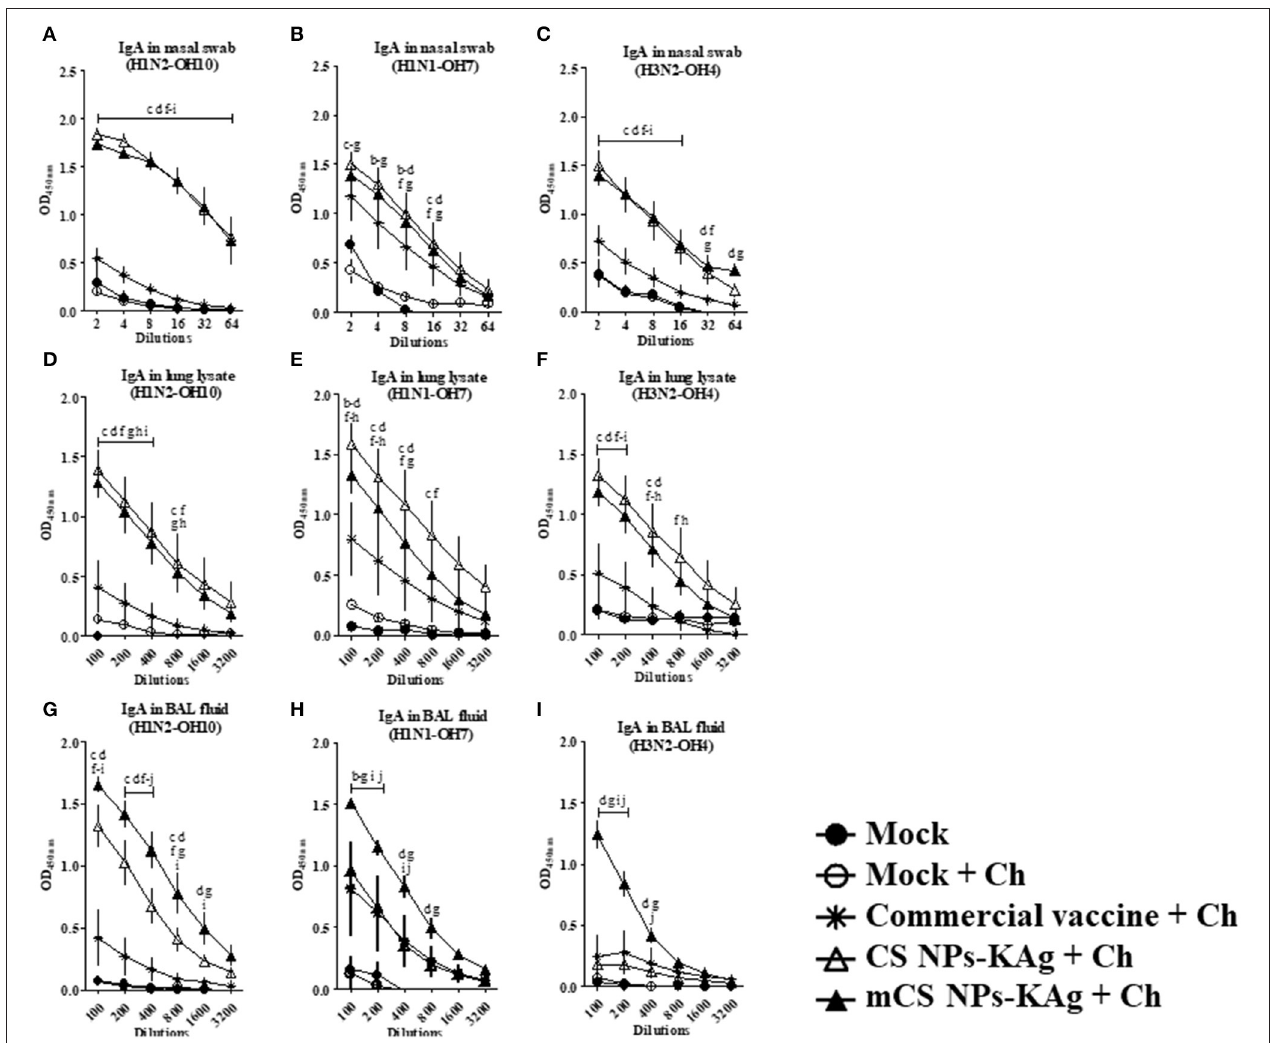
FIGURE 2 | Mannose-conjugated and unconjugated CS NPs based influenza (mCS NPs-KAg and CS NPs-KAg) vaccinates elicited higher cross-reactive secretory IgA antibody response in MDA-positive pigs post challenge infection. Pigs were prime-boost vaccinated with mCS NPs-KAg or CS NPs-KAg vaccine (containing H1N2-OH10 virus) intranasally or commercial vaccine (containing H1N1, H1N2, and H3N2 viruses) intramuscularly and at day post vaccination 35 challenged with a heterologous H1N1-OH7 virus. On day six post-challenge secretory IgA antibodies in nasal swab, lung lysate, and BAL fluid samples against (A,D,G) H1N2-OH10; (B,E,H) H1N1-OH7; and (C,F,I) H3N2-OH4 viruses were analyzed by ELISA. Data represent the mean value of three to four pigs ± SEM at all indicated dilutions. Statistical analysis was carried out using two-way ANOVA followed by a Bonferroni test. Each letter on the line graph indicates the significant difference between the groups at the marked sample dilution: b, c and d indicate the difference between mock group compared to commercial vaccine + Ch, CS NPs-KAg + Ch, and mCS NPs-KAg + Ch, respectively; e, f, and g indicate the difference between mock + Ch group compared to commercial vaccine + Ch, CS NPs-KAg + Ch and mCS NPs-KAg + Ch, respectively; h and i indicate the difference between commercial vaccine + Ch compared to CS NPs-KAg + Ch and mCS NPs-KAg + Ch, respectively. j indicate the difference between CS NPs-KAg + Ch compared to mCS NPs-KAg + Ch. A p < 0.05 was considered statistically significant. Ch, Challenge.